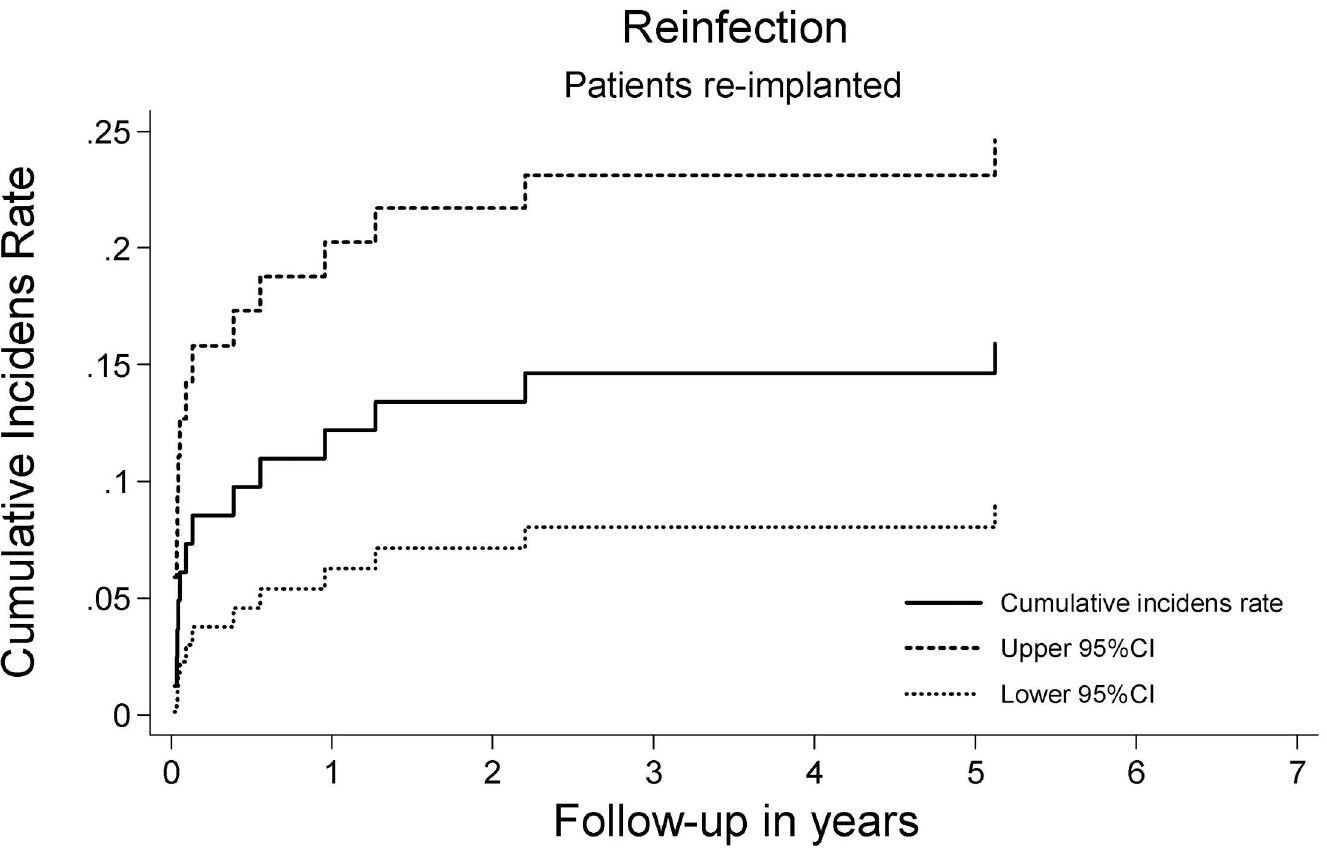
Fig 2. Re-infection. Cumulative incidencecurve on re-infection after treatment for chronic periprosthetic hip joint infection in 81 patients undergoing re- implantation followinga two-stage revision strategy in the presence of competing events, death and open aseptic revision.